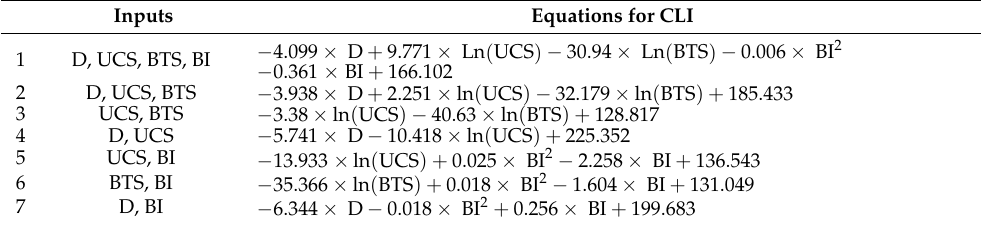
Table 9. Results of multi-variable non-linear regression of CLI as function of other rock properties. Inputs Equations for